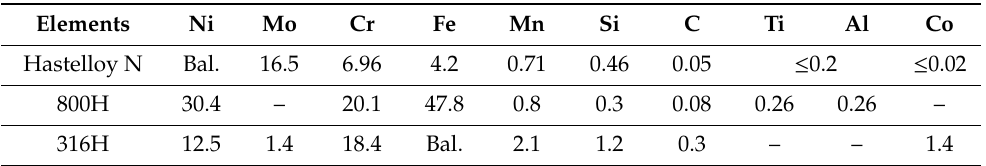
Table 1. Nominal material compositions (wt.%) of the Hastelloy N alloy, Alloy 800H and 316H stainless